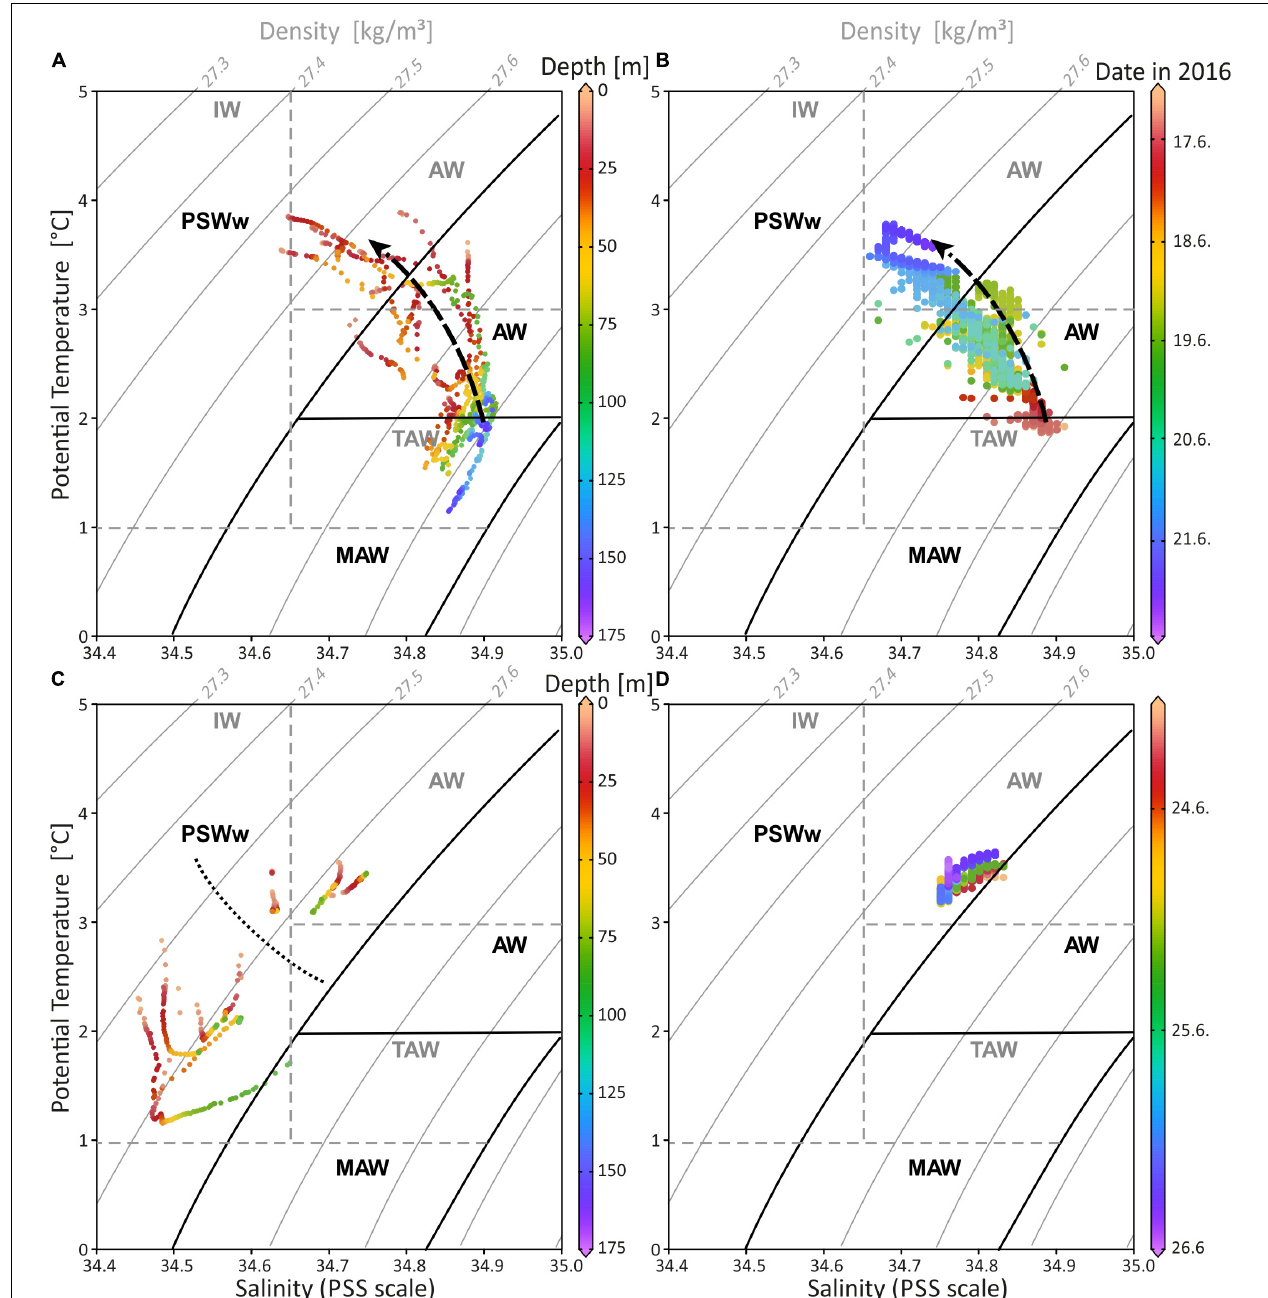
FIGURE 7 | Temperature-salinity diagram including depth and seawater density (sigma-theta) for CTD data of Mosselbukta (A) and Bjørnøy-Banken (C) in comparison with SaM Lander data for same areas, respectively (B,D) . Dashed arrow in (A,B) indicates the shift from relatively colder and more saline waters at the beginning of the measurements to warmer and less dense waters 6 days later. Dotted line in (C) separates the data from east (below) and west (above) the Polar Front. Water mass characteristics in black follow Rudels et al. (2000) and in dashed grey Cottier et al. (2005). AW, Atlantic Water from the south; MAW, Modified Atlantic Water from the Arctic Ocean; PSWw, warm Polar Surface Water; IW, Intermediate Water; TAW, Transformed Atlantic Water ( ∼= MAW).